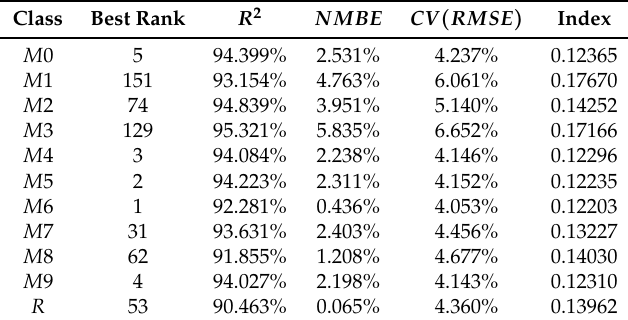
Table 5. Rank of models. The best of each